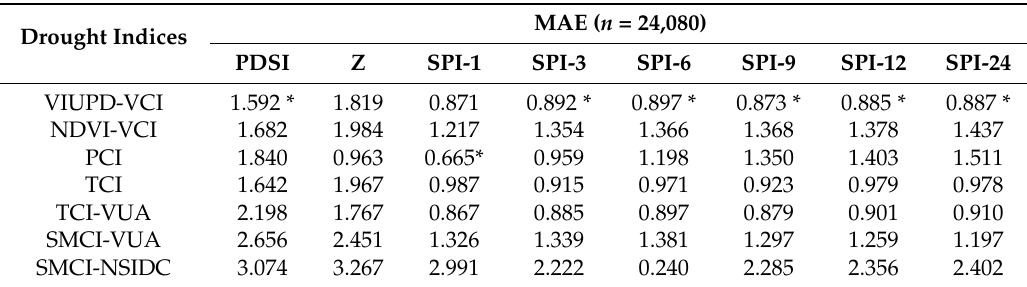
Table 5. Comparisons of MAE between VIUPD-derived VCI and other commonly used remote sensing-based single drought